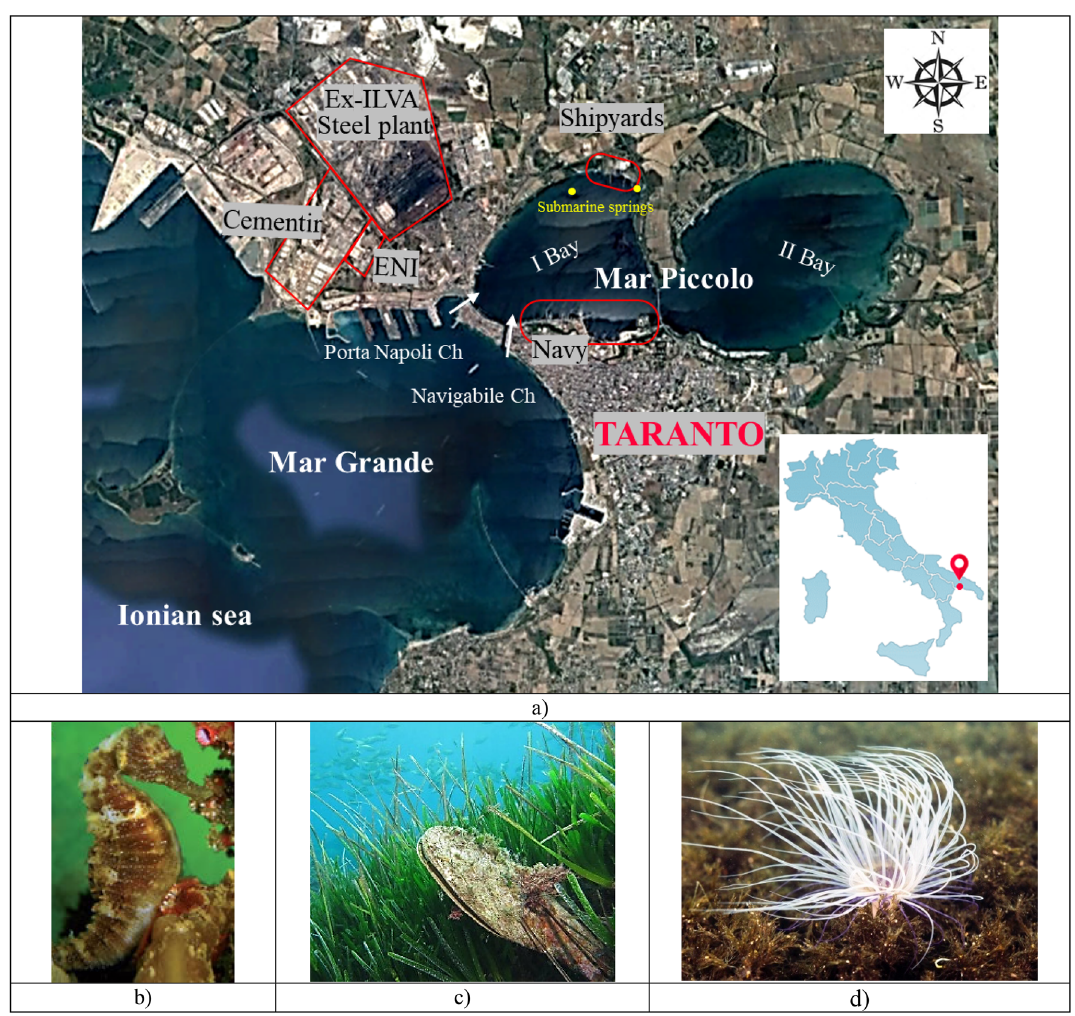
Figure 1. Gulf of Taranto in the South of Italy ( a ); ( b – d ) Photographs capturing the biodiversity in the Mar Piccolo and some typical protected species in the I Bay (e.g. seahorse, Pinna nobilis, Sabella spallanzani respectively). The map was obtained through Google Earth Software (https ://www.googl e.it/intl/it/earth /) and further modified with Power Point Software—License to Polytechnic University of Bari (Italy). The photos of protected species ( b ), ( c ) and ( d ) are credits by Cipriano G. under CC BY open access